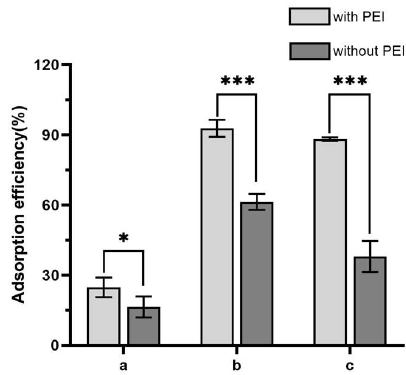
Figure 3. The adsorption efficiency of paper@epoxy@PEI-DFFPBA to tea polyphenol (a), Salmonella Typhimurium (b), and Staphylococcus aureus (c) with and without PEI modification. Bars show the means and the error bars show standard deviations. Asterisks indicate significant difference levels, * p < 0.05, *** p < 0.001.